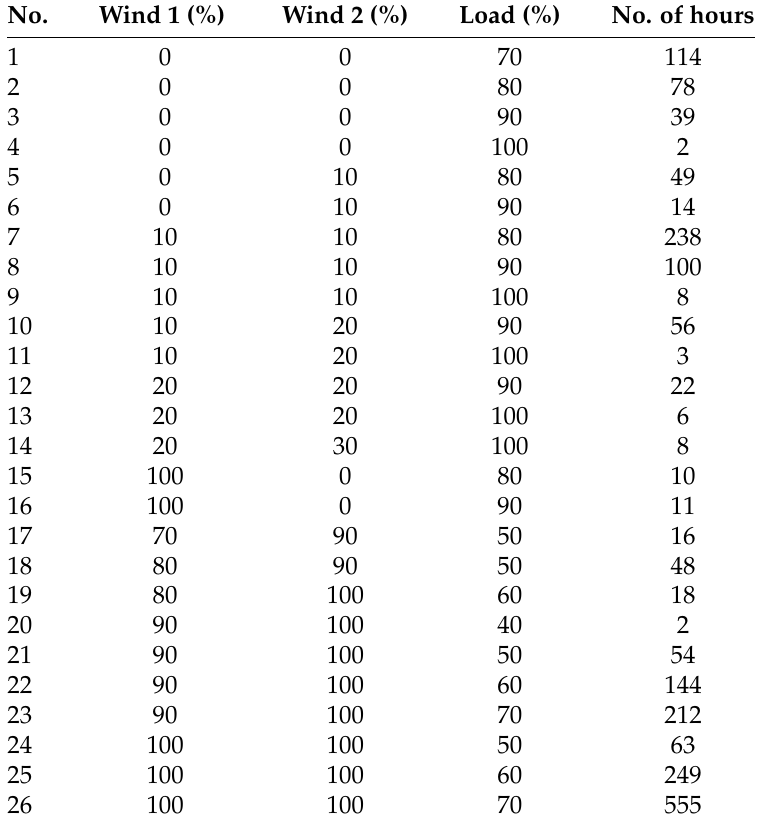
Table 2. Critical case scenarios obtained from [25].